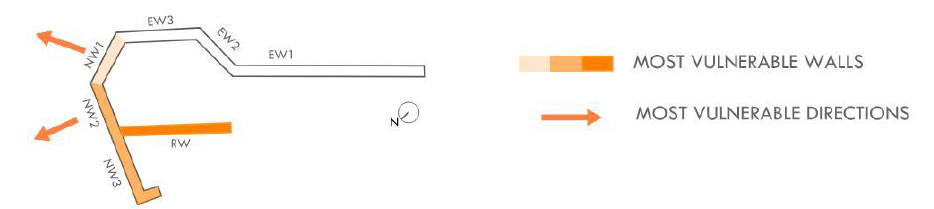
Figure 24. Location of the most vulnerable walls and loading